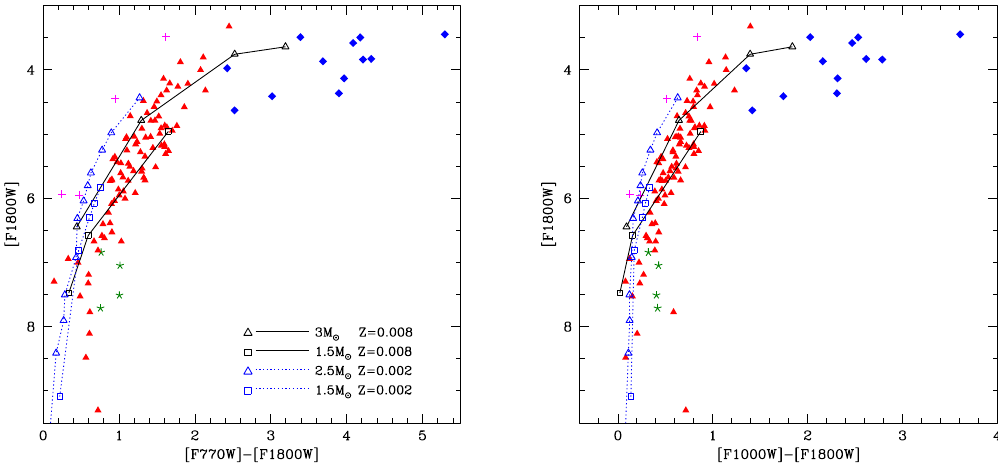
Figure 4. Distribution of carbon stars (red triangles) in the LMC in the colour-magnitude ([F770W] − [F1800W], F1800W) (left panel) and ([F1000W] − F1800W, F1800W) (right) diagrams. The meaning of the symbols is the following: blue diamonds: stars characterised by large infrared excess, not reproduced by single star modelling; magenta crosses: bright carbon stars; green asterisks: carbon stars with L < 5000 L (cid:12) . Solid lines indicate the evolutionary tracks of 1.5 M (cid:12) (squares) and 3 M (cid:12) stars (triangles) of metallicity Z = 0.008, dotted tracks refer to the evolution of 1.5 M (cid:12) (squares) and 2.5 M (cid:12) (triangles) stars, of metallicity Z =